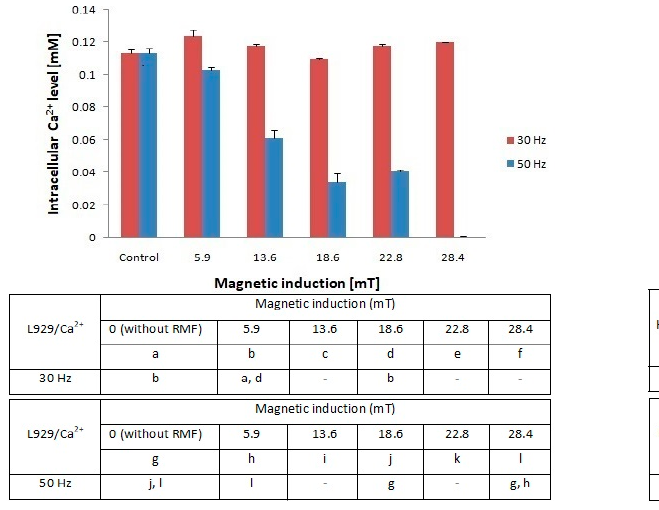
Figure 3. ROS accumulation (fluorescence intensity; DCFDA) in L929 ( a ) and HaCaT ( b ) cell cultures after 4-h exposition to different magnetic induction and frequency of RMF (all samples were compared to control; p -values < 0.05 were considered significant and were represented by small letters).